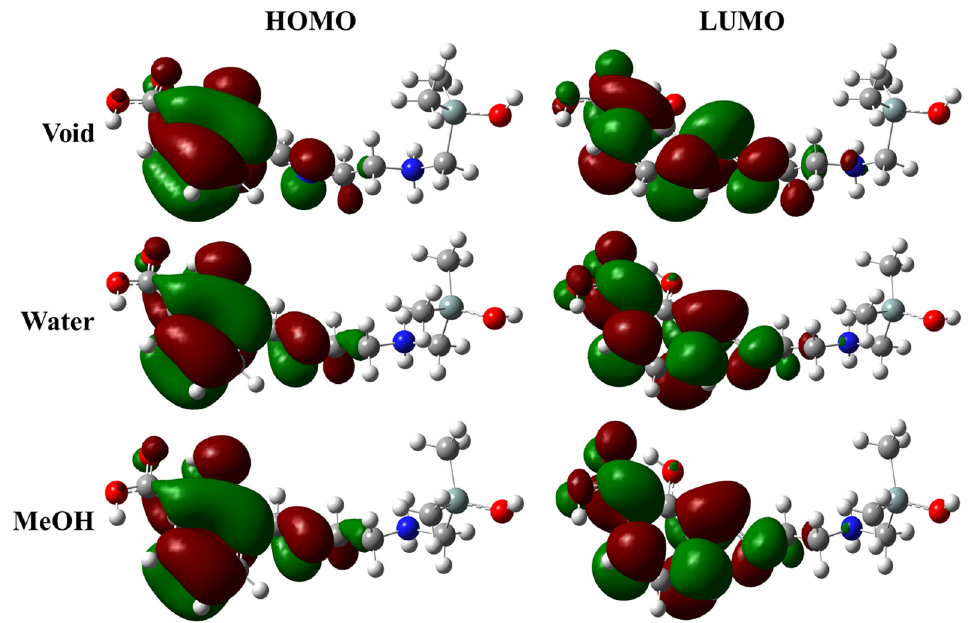
Figure 11. HOMO and LUMO images for the optimized SB-H-silanol molecule in vacuum, water, and methanol.